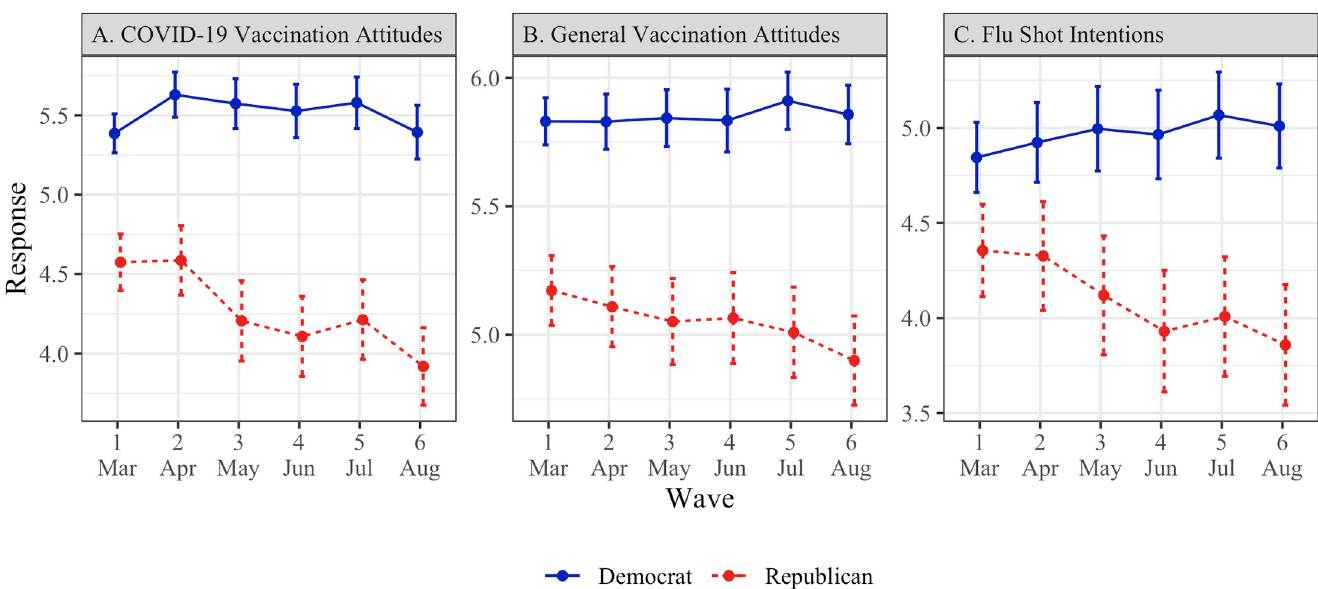
Fig 1. Vaccination attitudes and intentions by political affiliation (March–August 2020). Points represent means, and error bars represent 95% confidence intervals. All scale responses range from 1 to 7.